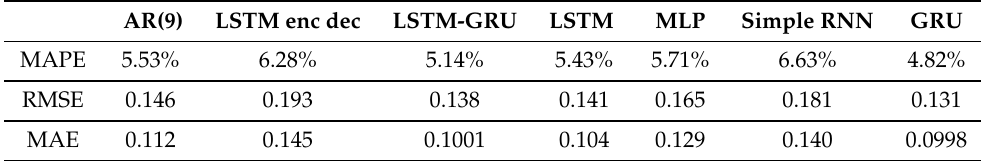
Table 5. Forecast errors for the test dataset: 15 october–20